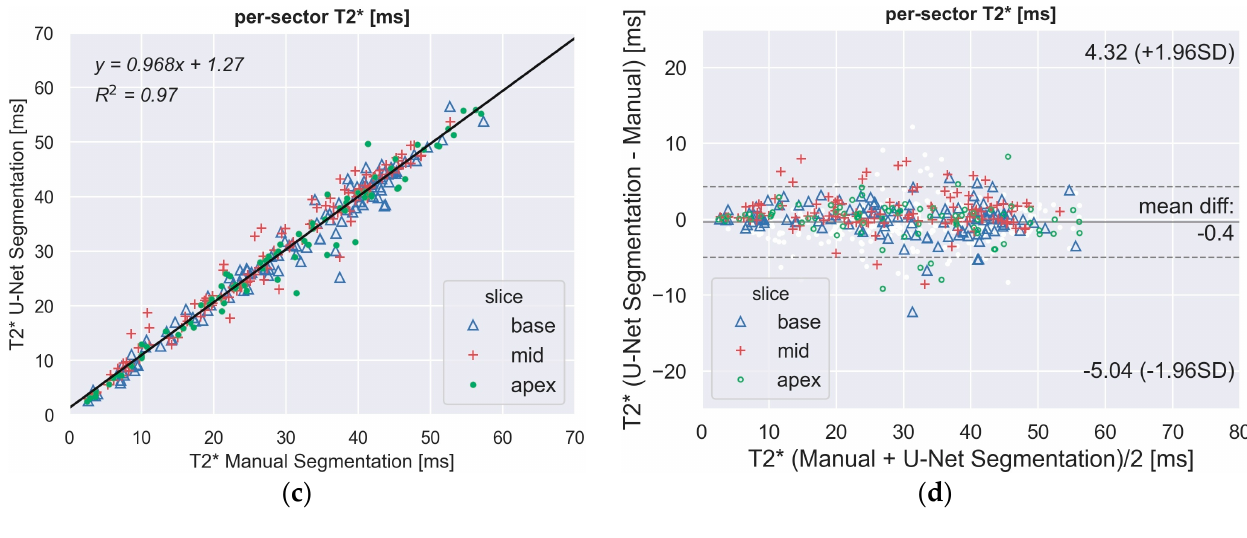
( c ) ( d ) Figure 3. ( a , c ) Scatter plots demonstrating a high correlation between fully-automated DL method and manually processed segmental T2* values. The segments of the three slices (basal, mid-ventricular, apical) are indicated by different markers. ( b , d ) Bland–Altman plot showing the excellent agreement between the manual and the proposed DL method for the regional quantitative analysis of T2*. Middle line denotes mean. Dashed lines denote ± 1.96 standard deviations. Table 3 shows the efficacy of the U-NET in differentiating the normal from pathological T2* values. The sensitivity was under 80% for three myocardial segments, while specificity was always very strong (high 90’s). The accuracy was very high (high 90’s). The global heart T2* value was always correctly classified. Table 3. Performance evaluation of automated identification of patients with reduced T2*.